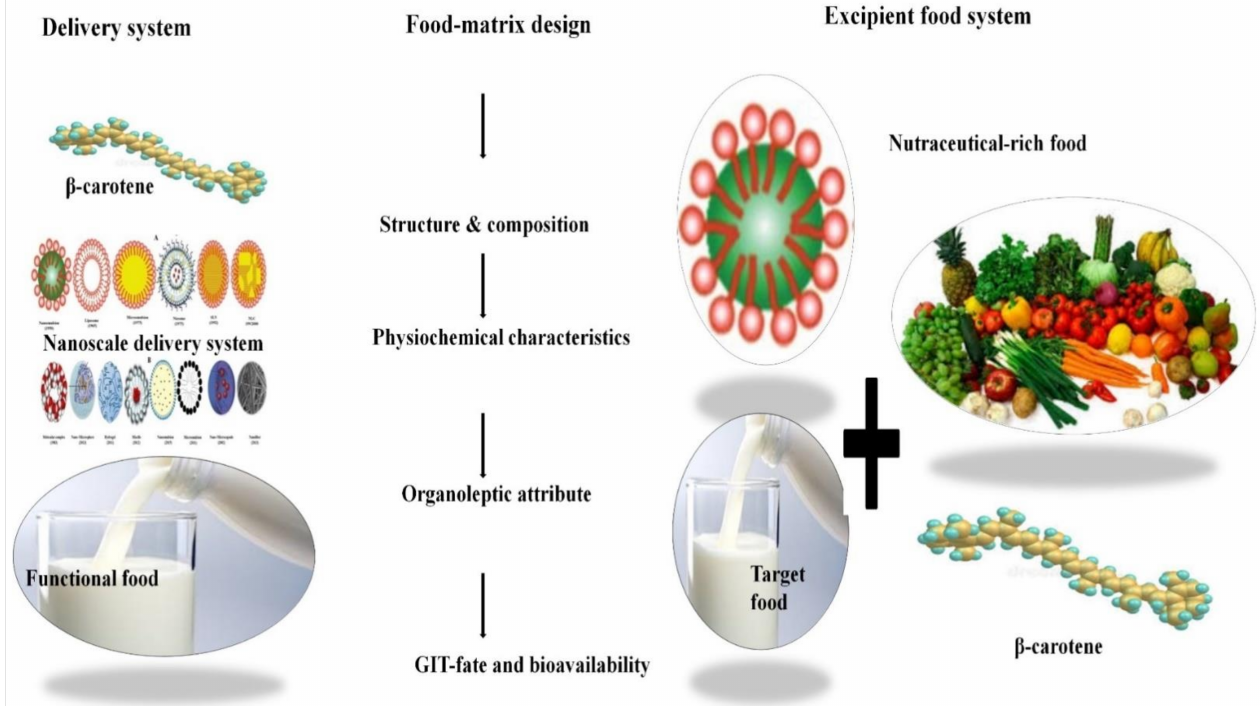
Figure 2. Strategy to improve the bioavailability of lipophilic constituents in